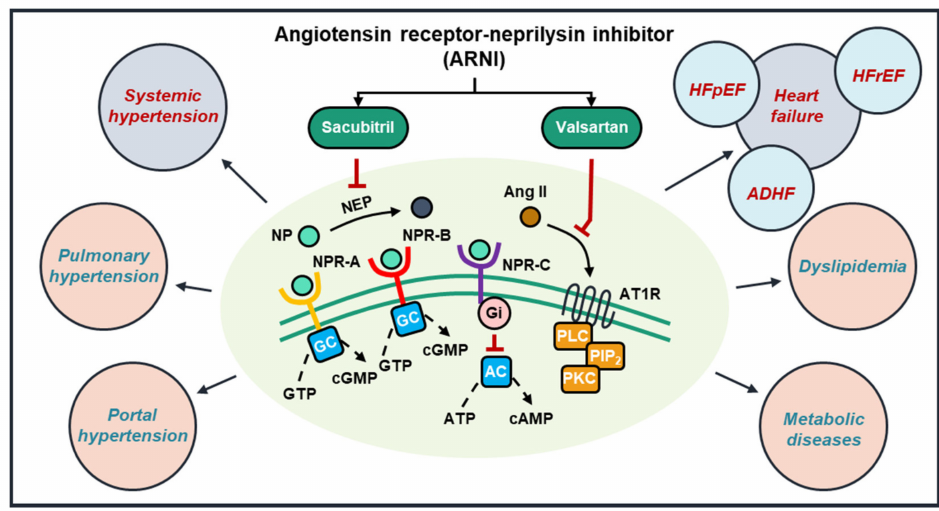
Figure 3. The promising roles of ARNI in cardiovascular diseases. ARNI (e.g., sacubitril/valsartan) inhibits neprilysin (NEP) and the binding of angiotensin II to its receptor (AT1R), preventing the activation of intracellular signaling cascades. In experimental and clinical studies, ARNI consistently lower blood pressure in hypertensive subjects and improve mortality and clinical outcomes in HF, particularly HFrEF (blue circles). Additionally, several studies have documented potentially benefi- cial roles of ARNI in other cardiovascular and metabolic diseases, warranting further investigations (pink circles). (AC = adenylyl cyclase; ADHF = acute decompensated HF; Ang II = angiotensin II; ATP = adenosine triphosphate; AT1R = angiotensin receptor type 1; cAMP = cyclic adenosine monophosphate; cGMP = cyclic guanosine monophosphate; GC = guanylyl cyclase; Gi = inhibitory G-protein; GTP = guanosine triphosphate; NEP = neprilysin; NP = natriuretic peptide; NPR = natriuretic peptide receptor; PIP 2 = phosphatidylinositol bisphosphate; PLC = phospholipase C; PKC = protein kinase